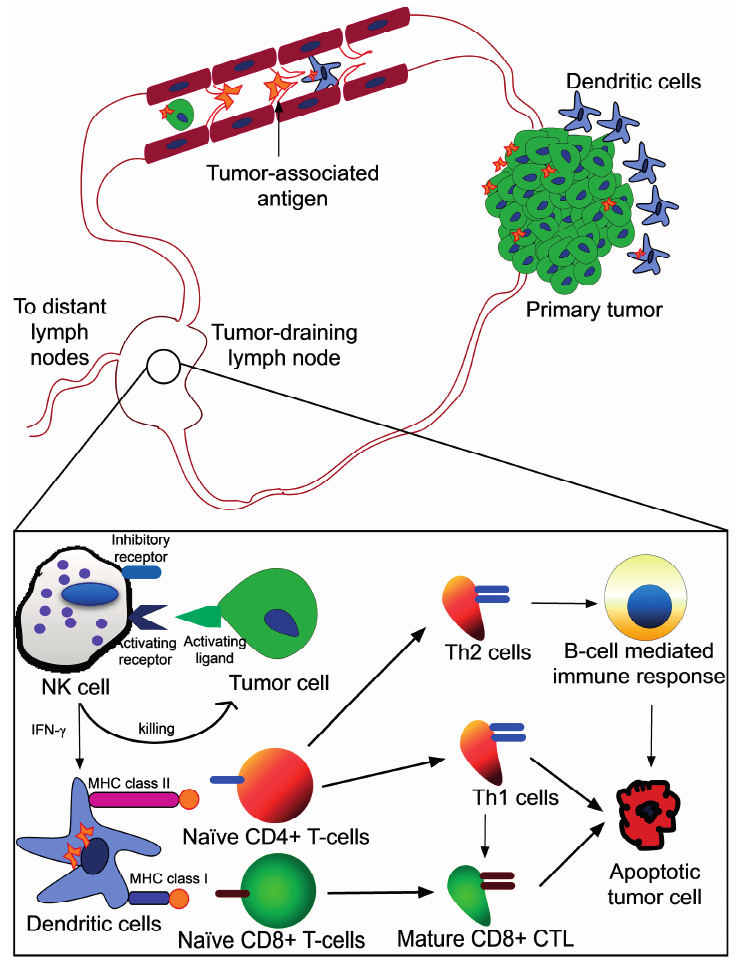
Figure 3. Immune responses in the TDLN: Tumor-associated antigens (TAA) can elicit an anti-tumor immune response in the TDLN through three possible routes: (1) DC in the TDLN ingest TAA transported via passive flow through the lymphatic capillaries to activate naïve T-cells by cross-presentation of antigens; (2) Tumor-infiltrating DC internalize TAA at the primary site and are then transported to the TDLN to activate naïve T-cells; (3) Tumor cells in the TDLN directly present the antigens to naïve T-cells. Once cancer cells reach the TDLN, NK cells are activated that kill tumor cells using effector molecules such as TRAIL and perforins. Activated NK cells secrete immune stimulatory cytokines such as IFN- γ that further activate DC. TAA are presented to naïve T-cells in the TDLN. Antigen presentation on MHC class II molecules activates naïve CD4+ T-cells that differentiate into T-helper (Th) cells. Th2 cells induce cancer cell death via B-cells and Th1 cells directly mediate cancer cell death. Antigen presentation on MHC class I molecules activates naïve CD8+ T-cells that differentiate into cytotoxic T-cells (CTLs) to induce cancer cell